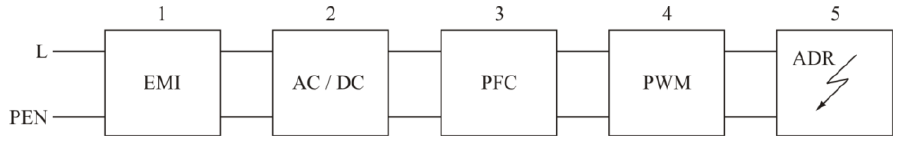
Figure 11. Block diagram of the pulse power supply as a functional block chain.